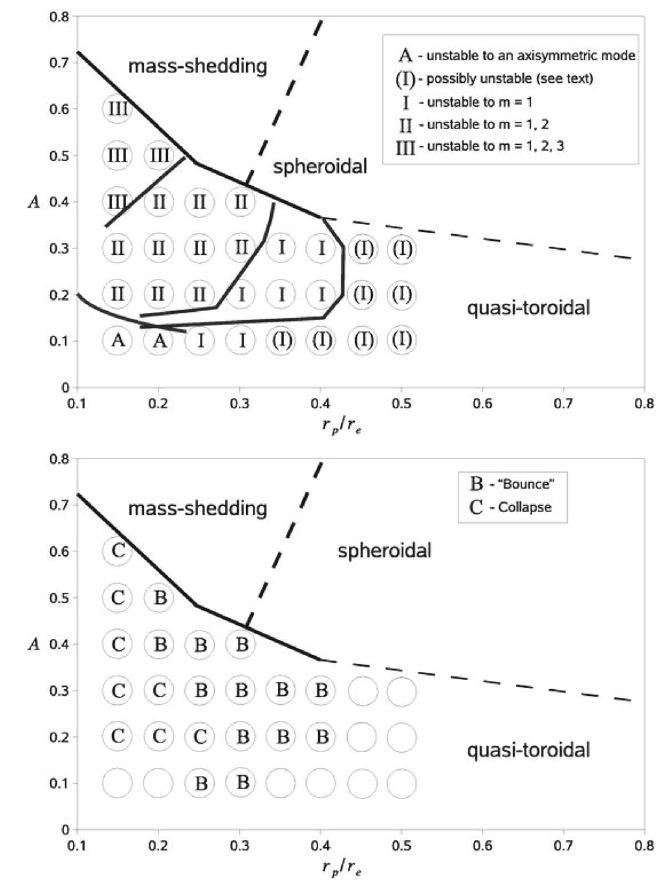
Fig. 31 Top panel: Stability of quasi-toroidal models with ρ c = 10 − 7 on the A – r p / r e plane where A is a constant controlling the degree of differential rotation. (We point out that, here, A does not coincide with A in Eq. (45), but it equals the A appearing in that equation divided by the equatorial coordinate radius r e ). A Latin number denotes the highest azimuthal order more that becomes unstable, i.e., I implies that only m = 1 is unstable, II implies m = 1 , 2 are unstable, and III implies m = 1 , 2 , 3 are unstable. Models denoted by (I) are either secularly unstable—growth times τ > t dyn (where t dyn is the dynamical timescale), or stable (see Zink et al. 2007). Models denoted by A exhibit an axisymmetric instability. The line in the lower left indicates the location of the sequence J / M 2 = 1, and the three lines inside the quasi- toroidal region indicate the locations of sequences with T / | W | = 0 . 14 (right), T / | W | = 0 . 18 (middle) and T / | W | = 0 . 26 (left). Lower panel: Remnants of the models from left panel, which are unstable with respect to nonaxisymmetric modes. The nonlinear behaviour has been analyzed by observing the evolution of the function minimum value of the lapse α min Models which show a minimum in this function are marked by B for bounce, while models exhibiting an exponential collapse of the lapse are marked by C for collapse. (Image reproduced with permission from Zink et al. 2007, copyright by